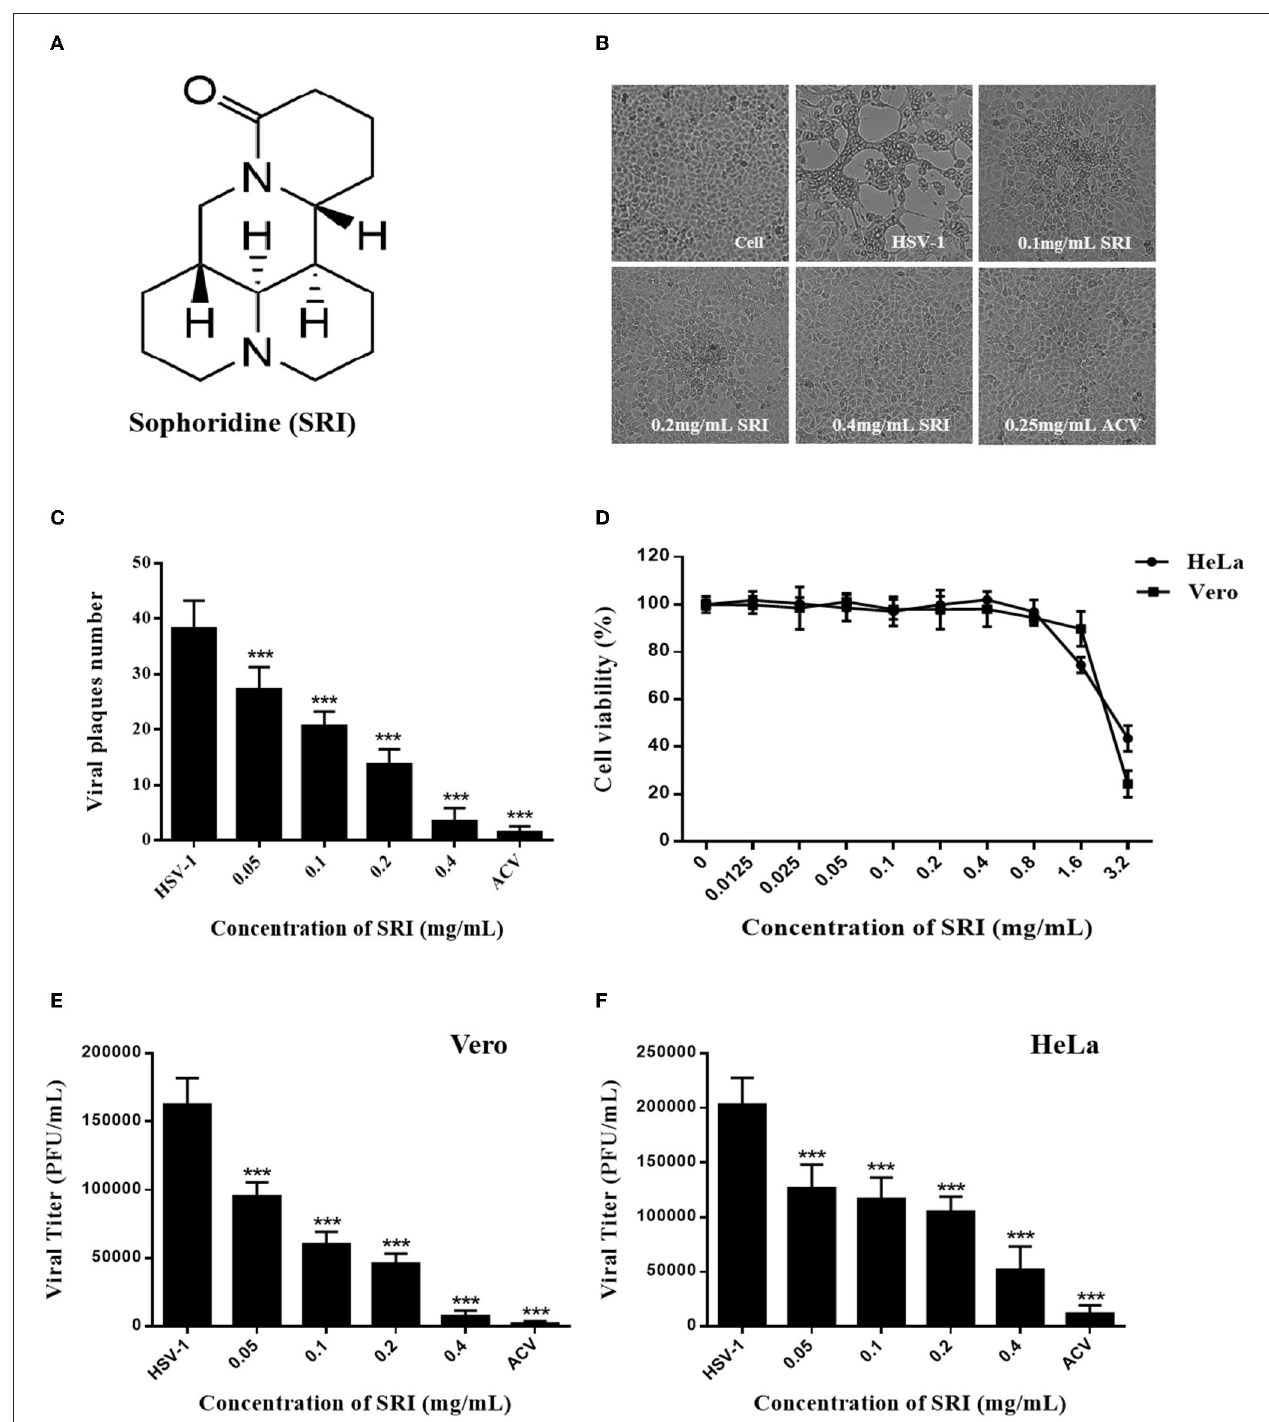
FIGURE 1 | Toxicities and inhibitory effects of SRI on HSV-1 in vitro . (A) The chemical structure of SRI. (B) The cells infected with HSV-1 (MOI = 1) were treated with SRI (0.1, 0.2, and 0.4 mg/mL) or ACV (0.25 mg/mL), and morphological changes of Vero cells were captured under an optical inverted microscope at 72h post-infection. (C) The cells infected with HSV-1 (MOI = 1) were treated with SRI or ACV, and the inhibitory effect of SRI was estimated by plaque assay. The number of plaques on Vero cells infected with HSV-1 was counted. (D) Vero and HeLa cells were treated with SRI (from 0.0125 to 3.2 mg/mL) for 48 or 72h, and cell viability was calculated by MTT assay. (E,F) Vero and HeLa cells were infected with HSV-1 (MOI = 1) and were then treated with SRI or ACV for 24h. The progeny virus was released after three cycles of freezing and thawing of the infected cells, and the progeny virus titer was determined by plaque assay. The results are given as mean ± SD. *** p < 0.001 vs. HSV-1